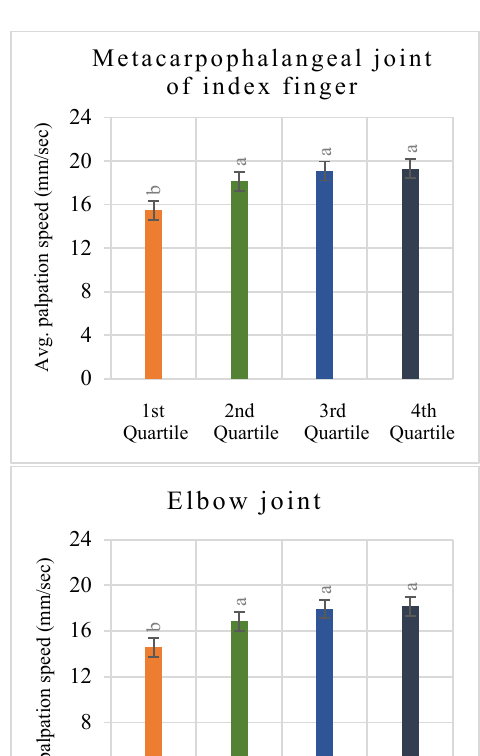
Figure 8. Relative stiffness difference between two virtual cylinders in quarterly subsets of the total number of trials. Means labeled without a common letter are significantly different ( p < 0.05).